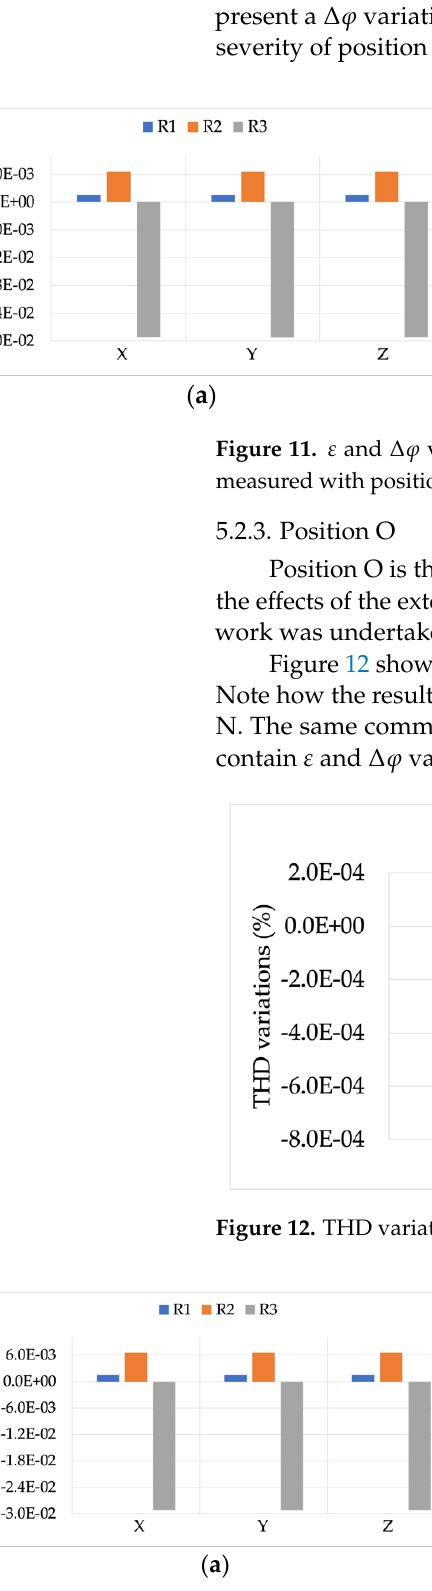
Figure 13. 𝜀 and ∆𝜑 variations (( a , b ), respectively), compared to position L, for the three signals measured with position